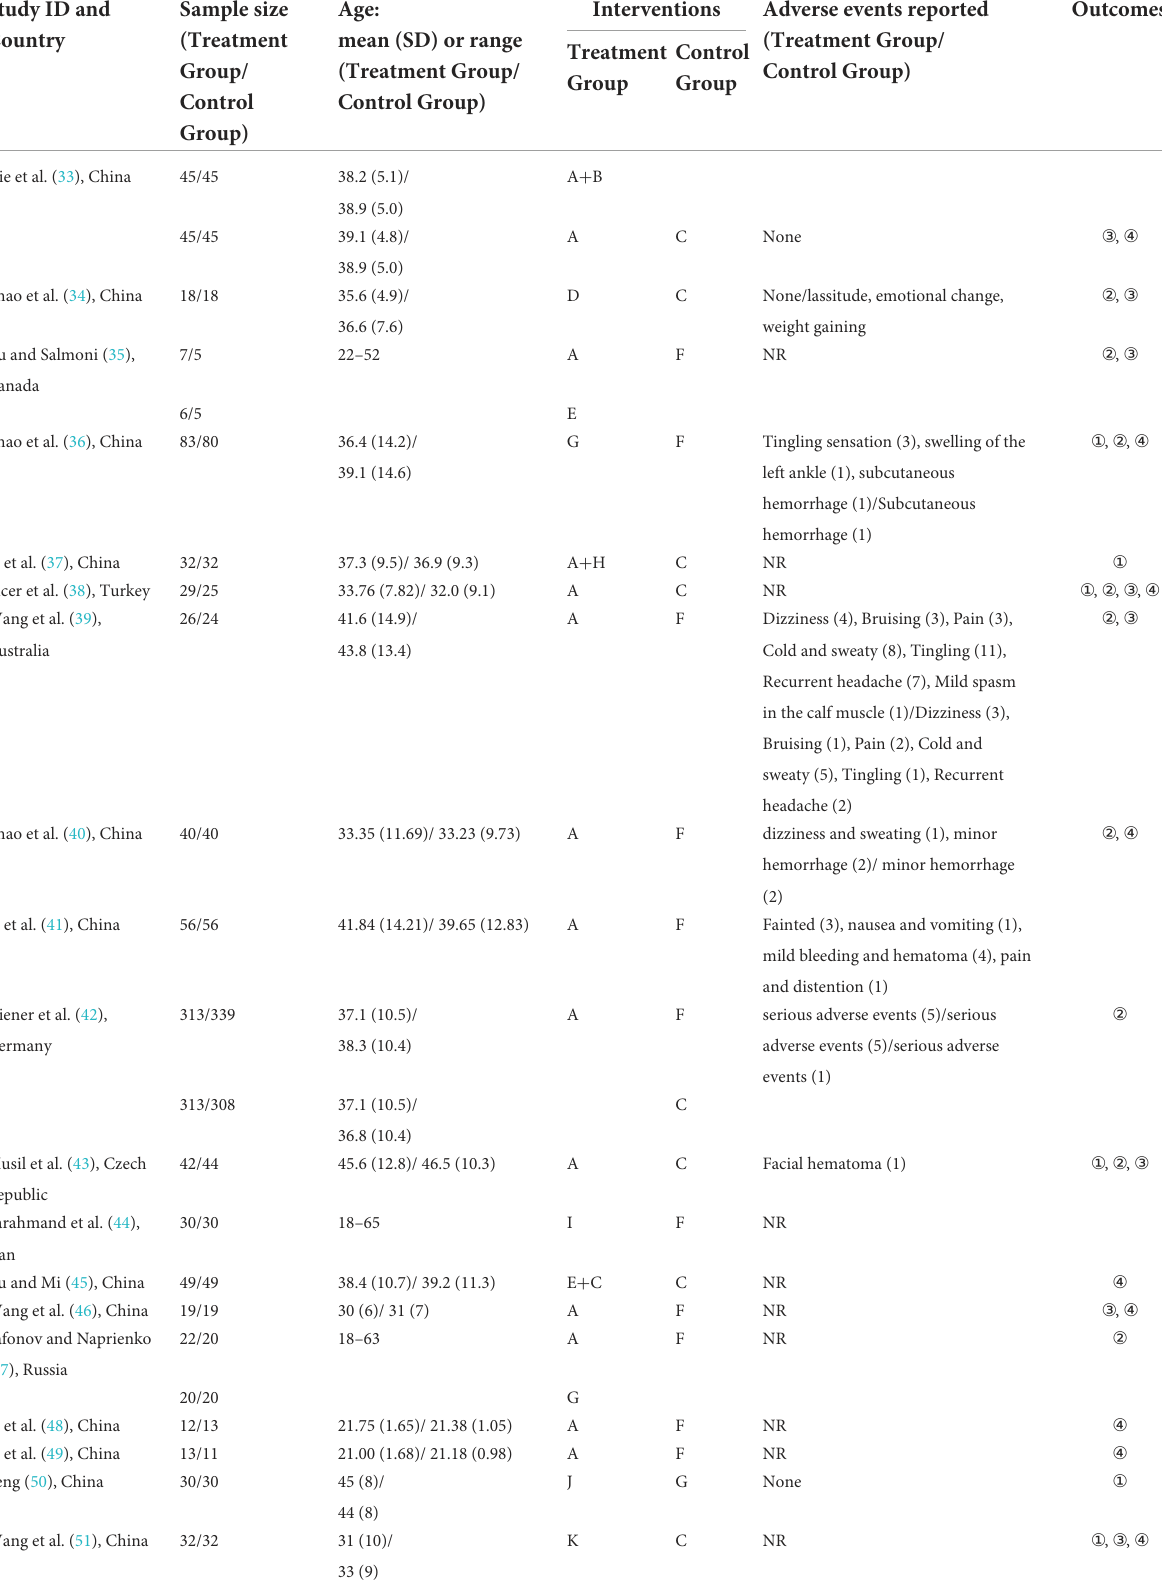
TABLE 1 Main characteristics of the included